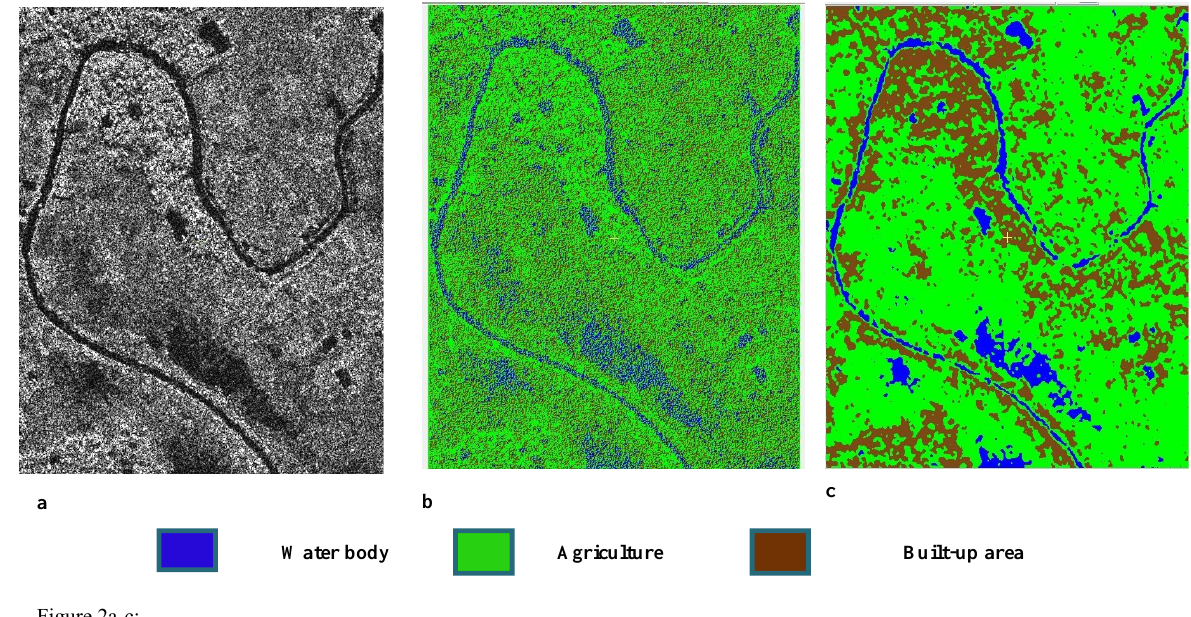
(a) RISAT-II image of agriculture, built-up area and water bodies, (b) Output image obtained by applying “Lucieer et al’s LBP analysis and ISODATA” on (a), (c) Output image obtained by applying “proposed LBP and ISODATA” on (a).